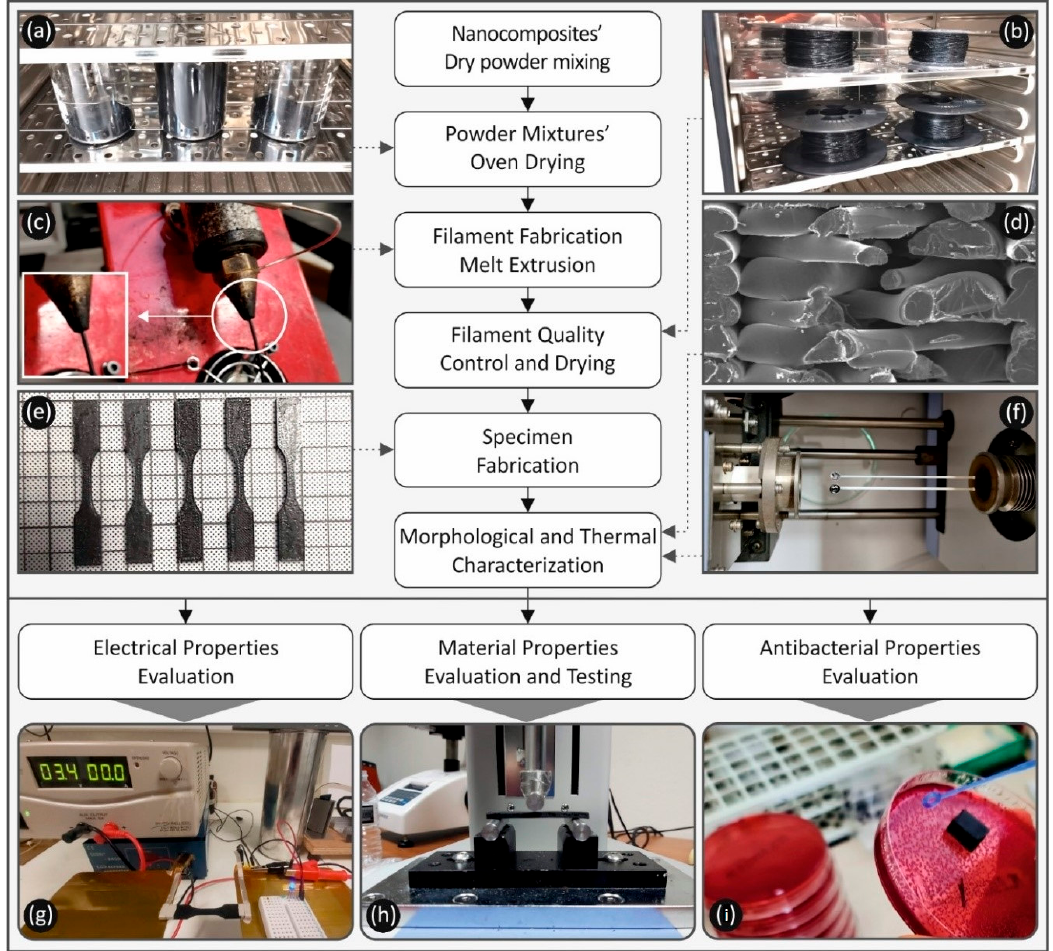
Figure 1. Flow chart illustrating the different steps to manufacture the filaments, as well as the 3D printed specimens and